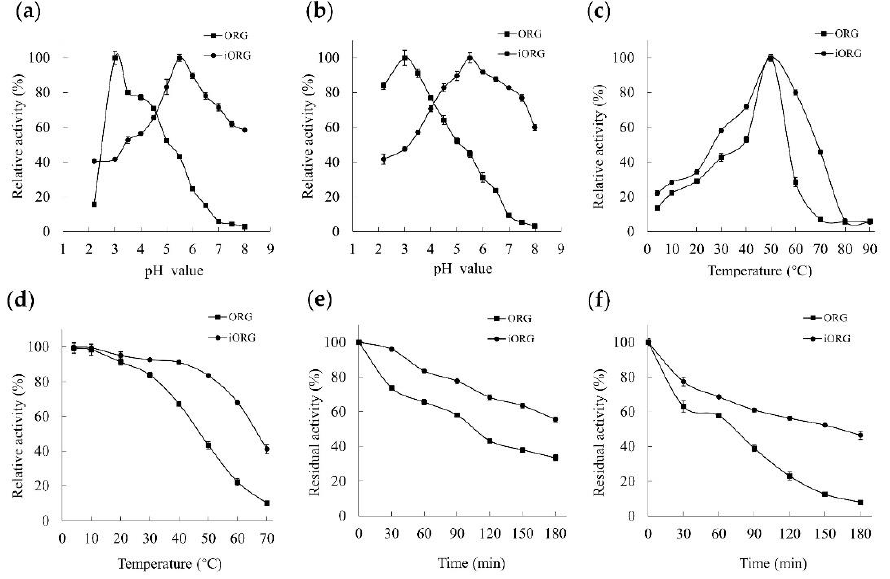
Figure 3. Relative activity of ORG ( ■ ) and iORG ( ● ) with respect to pH and temperature. ( a ): Effects of pH on ORG and iORG; ( b ): pH stability of ORG and iORG; ( c ): effects of temperature on ORG and iORG; ( d ): thermal stability of ORG and iORG; ( e ): time-dependent thermal stability at 50 ◦ C; ( f ): time-dependent thermal stability at 60 ◦ C. The results represent the mean ± SD ( n = 3). iORG represents the immobilized enzyme obtained by immobilizing α -galactosidase isolated and purified from Oudemansiella radicata